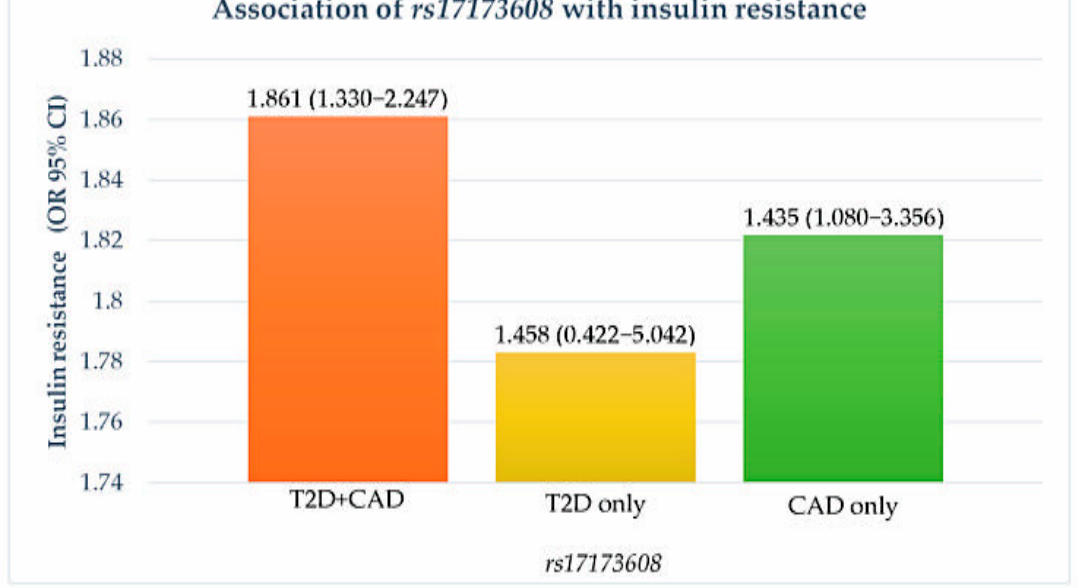
Figure 1. Association of rs17173608 with insulin resistance. OR: odds ratio; CI: confidence interval.